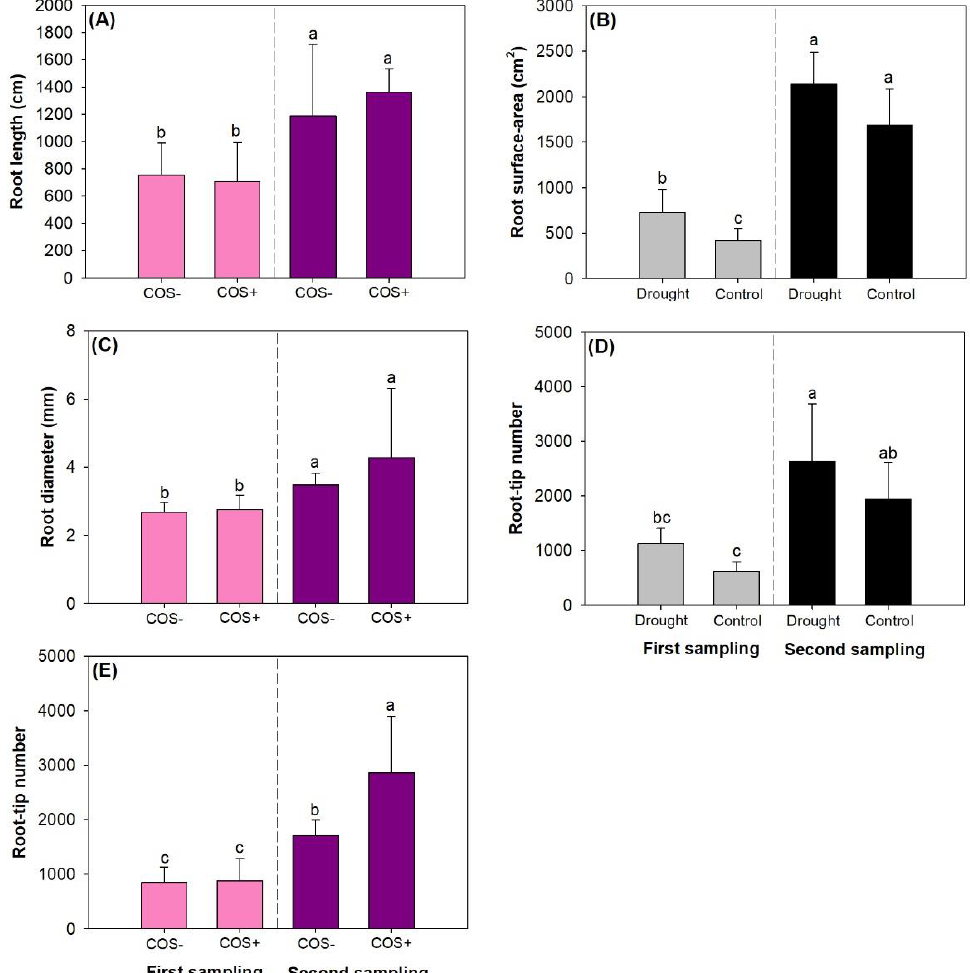
Figure 5. Root length ( A ), root diameter ( C ), and root-tip number ( E ) in two harvests of Buddhist pine ( Podocarpus macrophyllus ) seedlings exposed to chitosan oligosaccharide (COS) addition (COS- vs. COS+) and root surface area ( B ) and root-tip number ( D ) to contrasting water availabilities (drought vs. irrigated control) in two harvests. Different letters indicate a significant difference according to Tukey’s test at the 0.05 level. Error bars stand for standard errors.